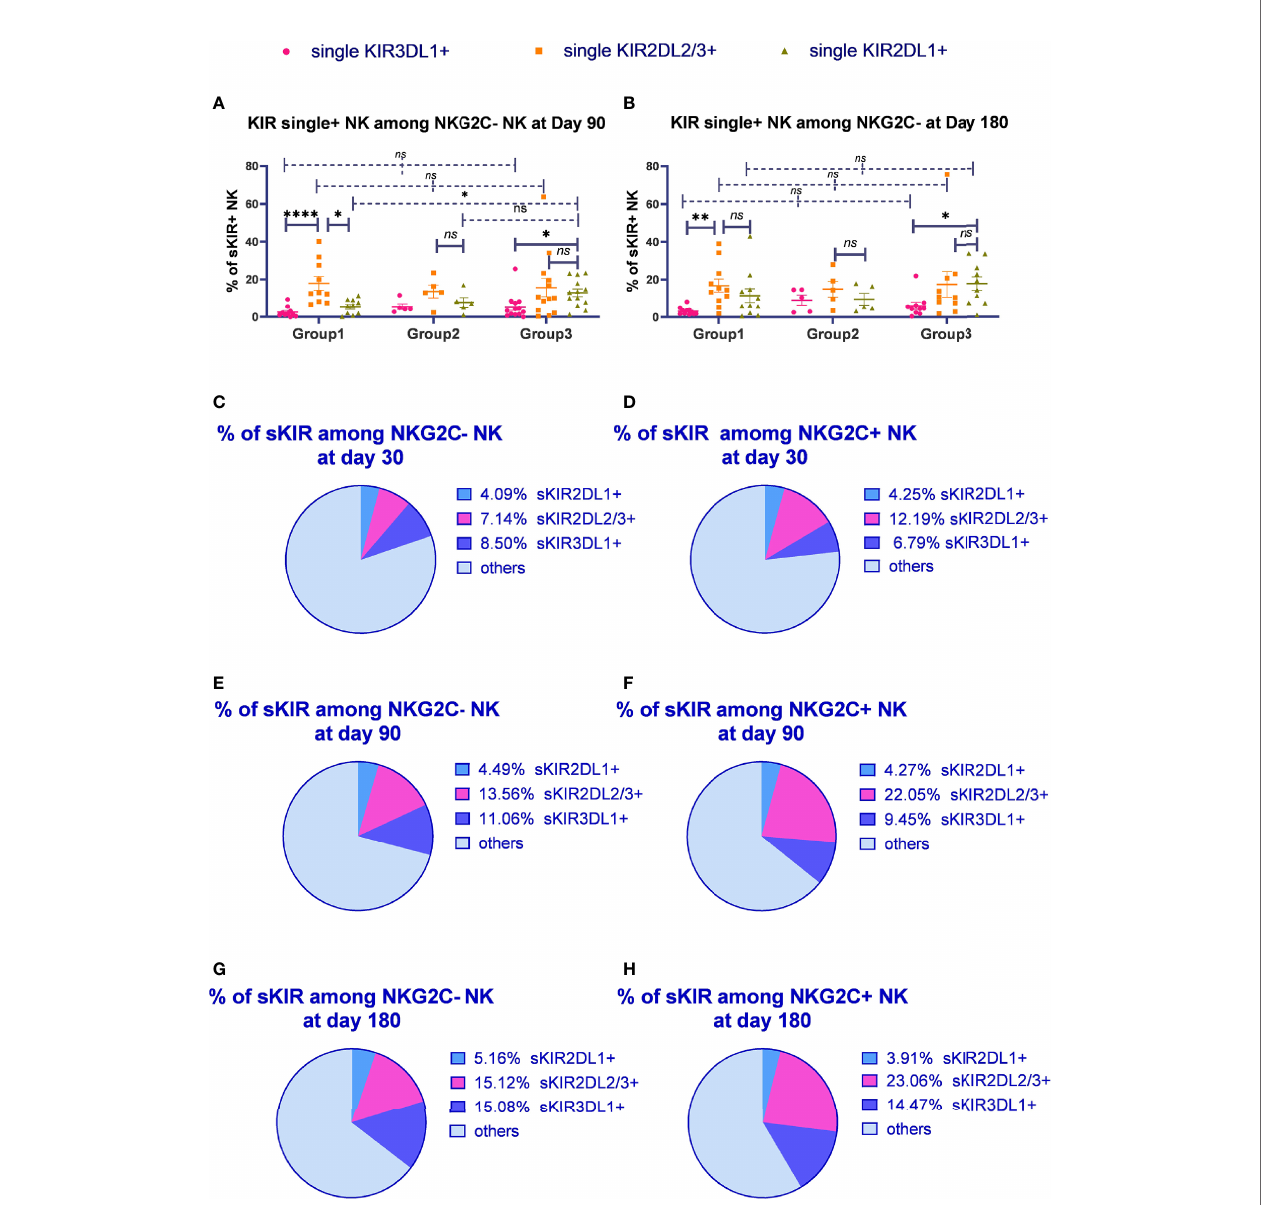
FIGURE 3 | The proportion of single KIR positive NK cells increased in both NKG2C + /NKG2A - NK cells and conventional NKG2C - /NKG2A - NK cells over time. sKIR2DL1+, single KIR2DL1 positive; sKIR2DL2/L3+, single KIR2DL2/L3 positive; sKIR3DL1+, single KIR3DL1 positive. The surface markers of peripheral blood mononuclear cells (PBMCs) from patients ’ fresh blood sample were analyzed by fl ow cytometry, performed in PBS at 4°C for 30 min following Fc blockade. (A, B) The proportion of KIR2DL2/L3 single-positive/NKG2C+ NK cells among the NKG2A- NK cells from the patients after HSCT with available data in group 1 (recipient- donor C1C1; day 90, n = 10; day 180, n = 11), group 2 (recipient-donor C1BW4; day 90, n = 5; day 180, n = 5), and group 3 (recipient-donor C1C2BW4; day 90, n = 13; day 180, n = 10). Each plot (triangle, circle, or square) represents one patient with the indicated receptor expression; middle horizontal lines show mean values for each group, and upper and lower horizontal lines show the standard error of the mean. * p < 0.05; ** p < 0.01; n.s.: not signi fi cant (Kruskal – Wallis H test). (C – H) The mean proportion of single KIR NK cells among NKG2C- and NKG2C+ NK cells from patients after HSCT with available data in the whole cohort on days 30 ( n = 54), 90 ( n = 80), and 180 ( n =